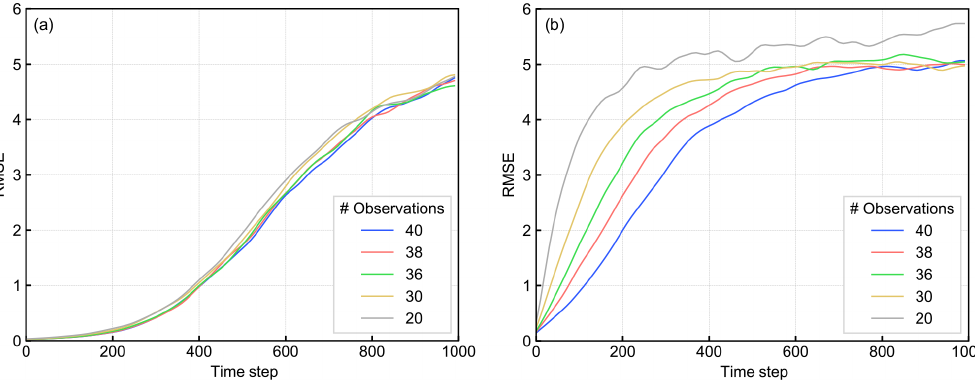
Figure 7. The mRMSE time series of the predictions of (a) LETKF-Ext and (b) RC-Obs with spatially sparse observation. Each color corresponds to the number of the observation points.